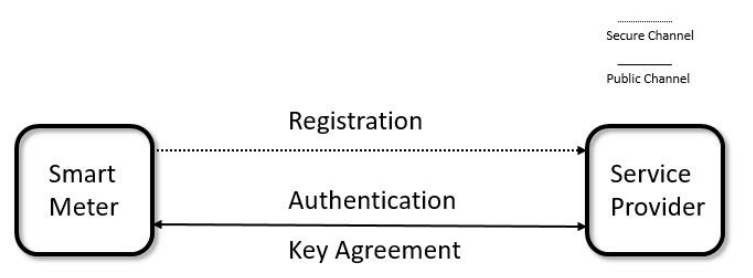
Figure 2. Communication model in smart